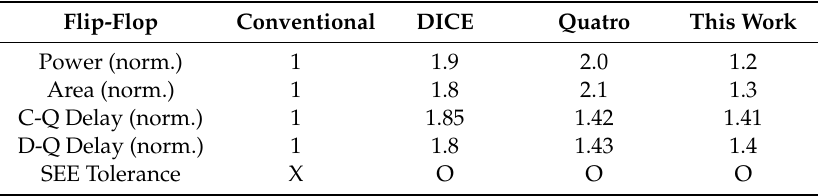
Table 2. Performance comparison of various radiation-hardened flip-flops.